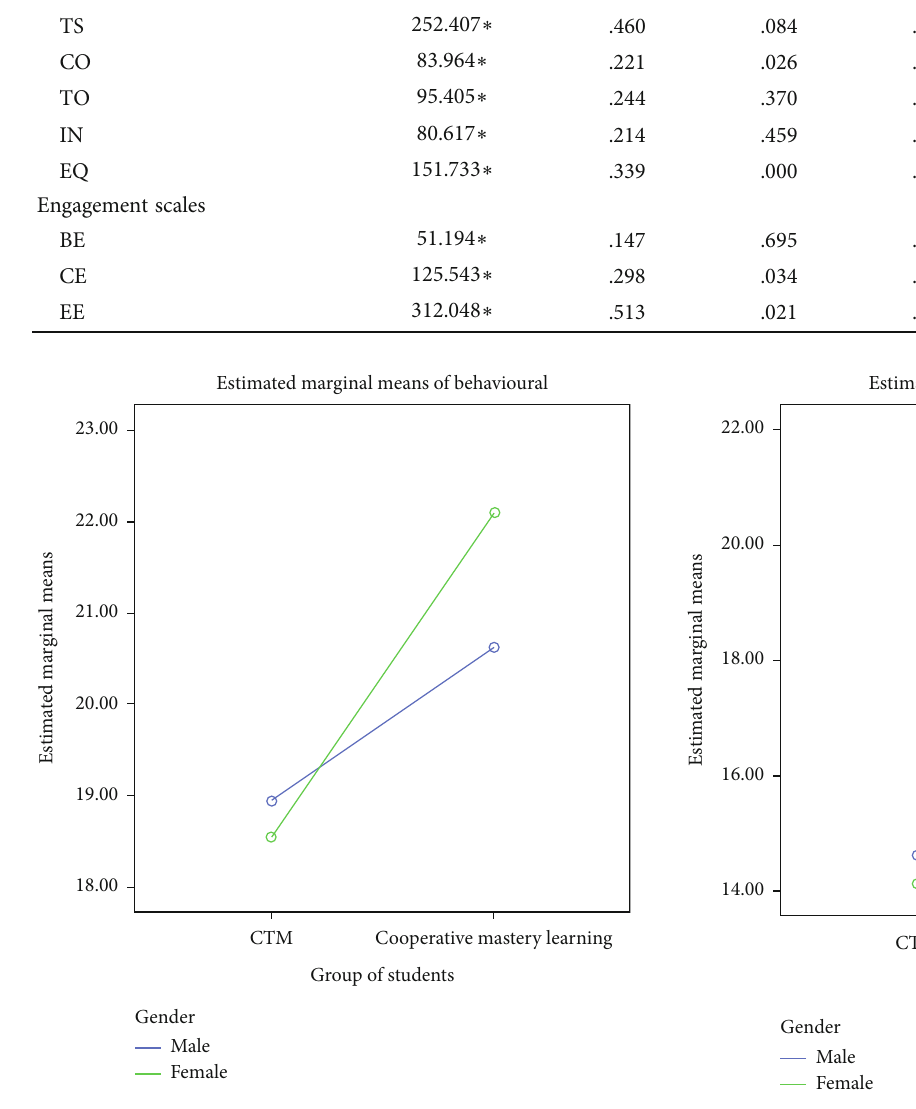
Figure 4: Interactions between treatment and sex for emotional